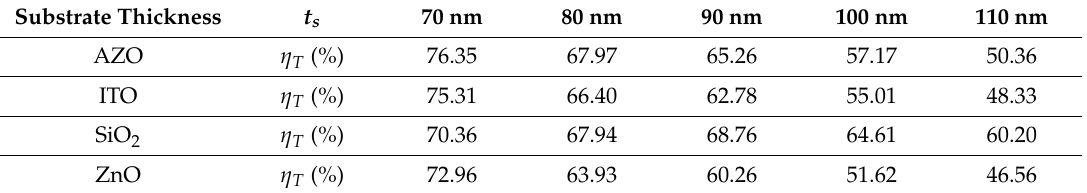
Table 3. Total efficiency η T at different substrate thickness and